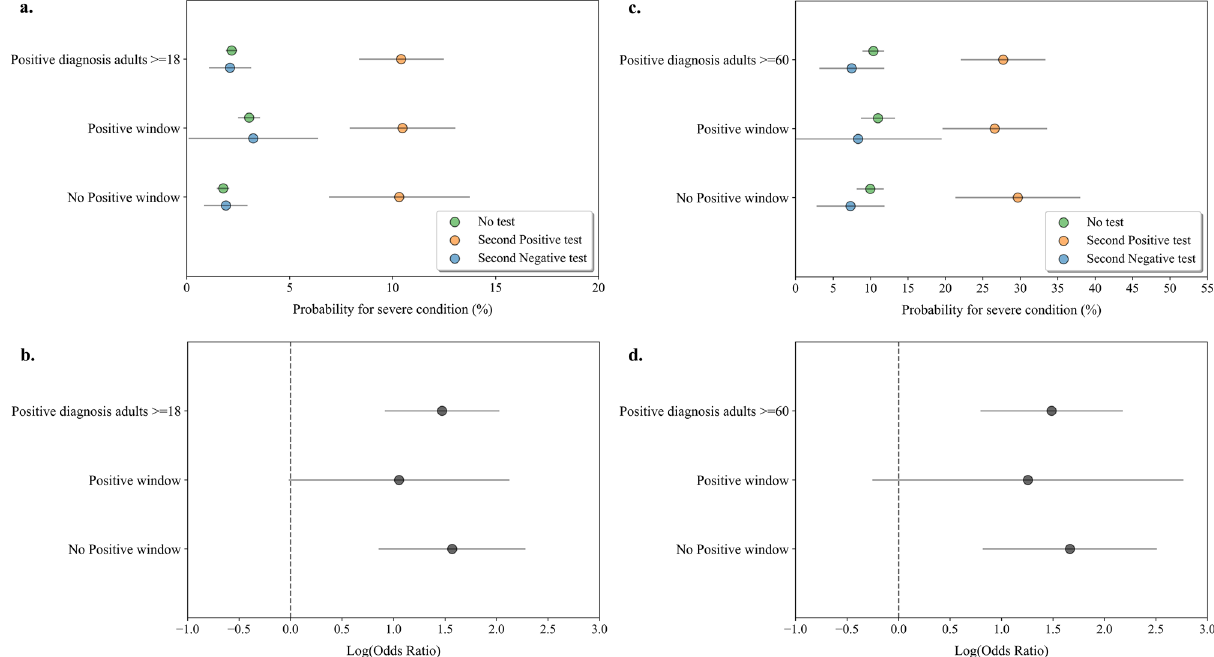
Figure 4. Probability analysis for disease deterioration following an early second NP SARS-CoV-2 PCR test in SARS-CoV-2 infected individuals with a “positive window”. ( a ) Probability of infected adults ≥ 18 years with a “positive window” tested a second time within the first week following diagnosis to deteriorate to severe COVID-19. Blue circles represent individuals who tested negative, orange circles represent individuals who tested positive and green circles represent individuals who were not tested in the week following diagnosis. Grey lines indicate 95% confidence intervals. ( b ) Log odds ratio (OR) for severe COVID-19 was calculated by the result of the early second PCR test in patients with a “positive window” and without. OR > 0 indicated larger risk in the population that tested positive compared to the population tested negative. Calculated log odds ratios are presented along with gray lines indicating 95% confidence intervals. ( c ) Same probability analysis for individuals ≥ 60 years old. ( d ) Log odds ratio (OR) for severe COVID-19 for individuals ≥ 60 years